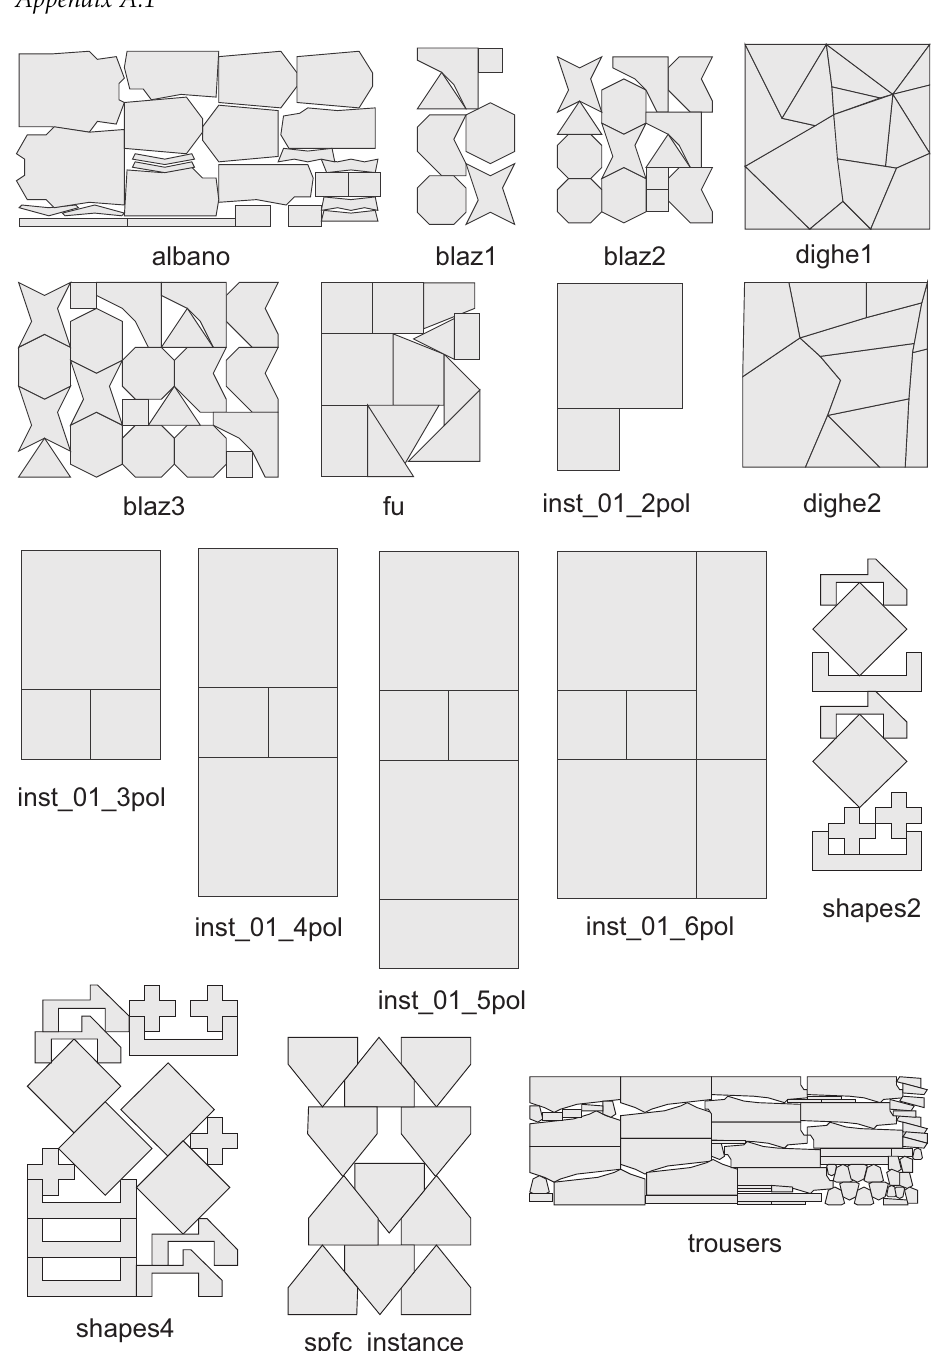
Figure A1. First batch of instances with connected